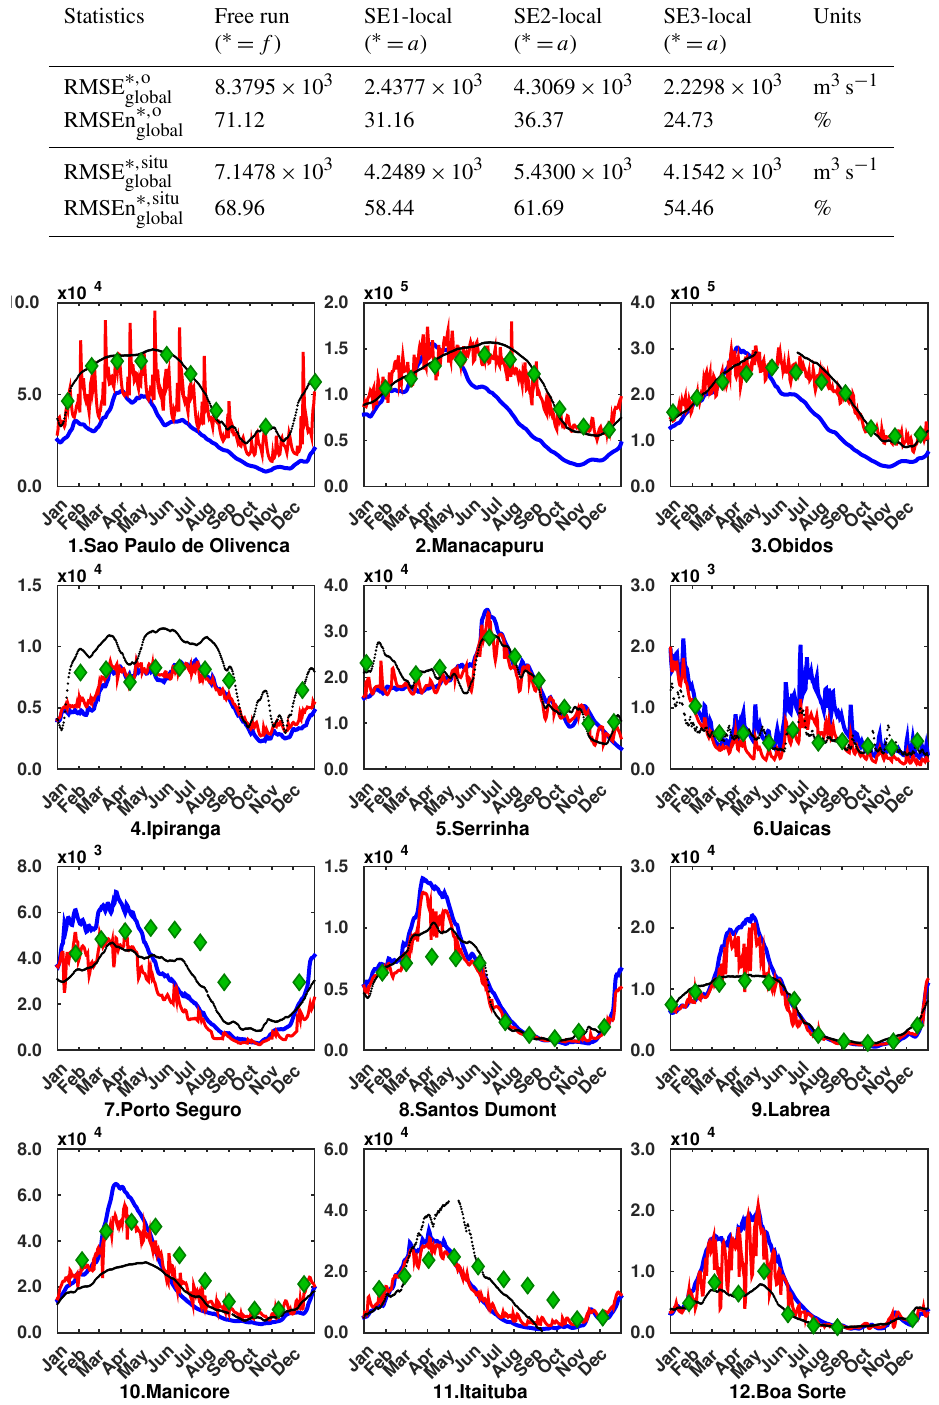
Figure 11. SE1-local ensemble mean analysis discharge (red line) compared to the free run discharge (blue line), the ENVISAT observed discharges (green markers) and the measured gauge discharges (black dots) over the year 2009. For each panel, the x -axis represents time (in days) and the y -axis represents discharge (in m 3 s − 1